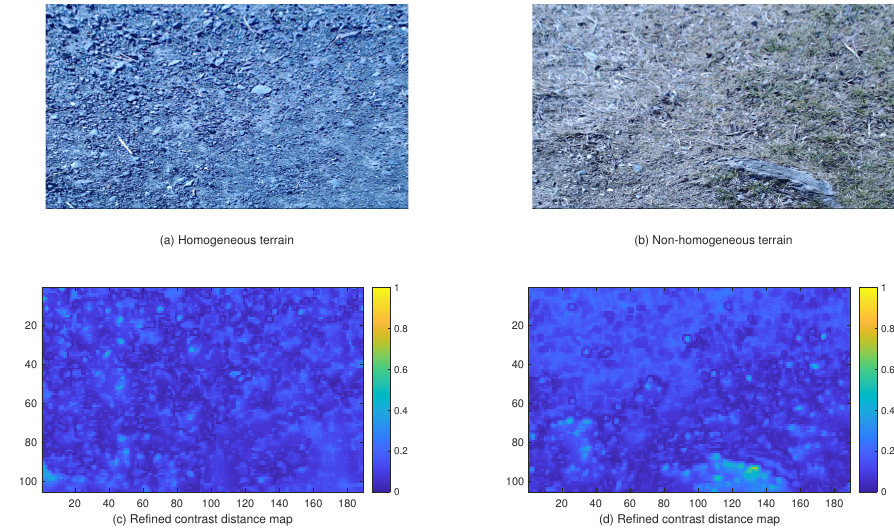
Figure 8. Refined contrast feature